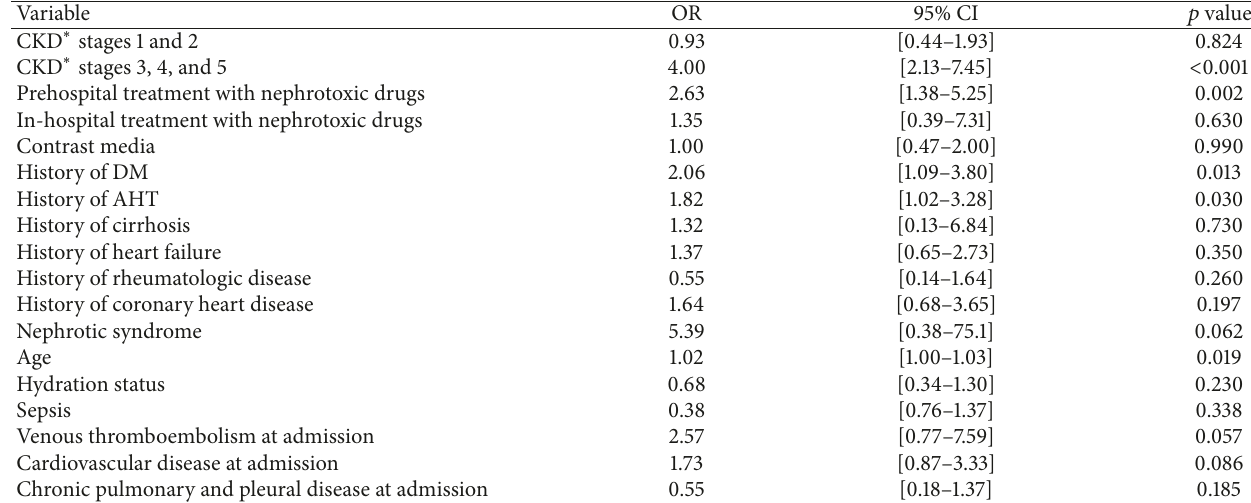
Table 2: Risk factors associated with EAKI, bivariate analysis.